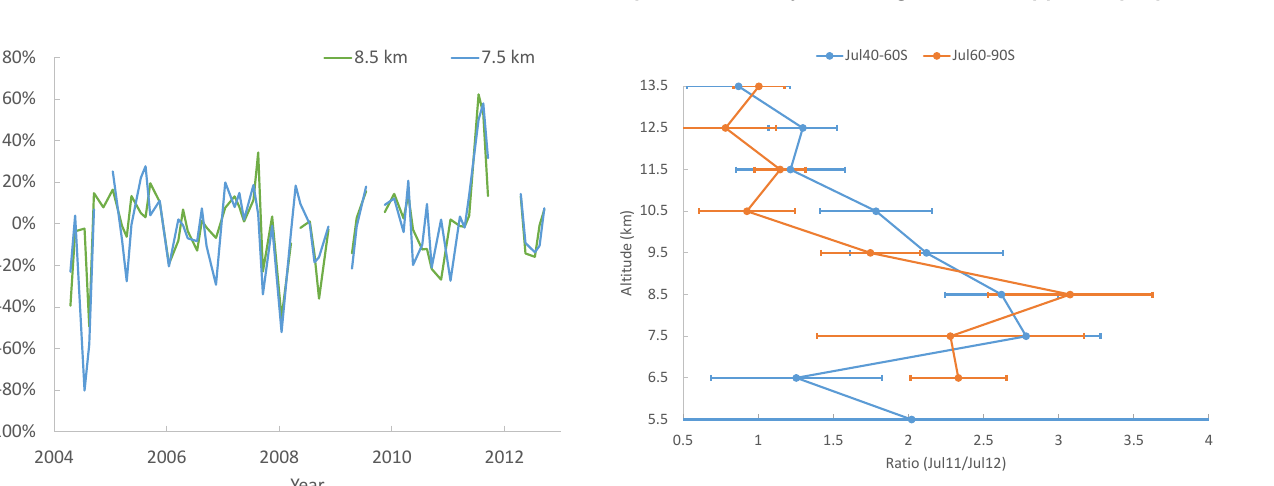
Figure 4. MAESTRO relative monthly median water vapour anomalies at 7.5 and 8.5km at southern high latitudes (60–90 ◦ S).